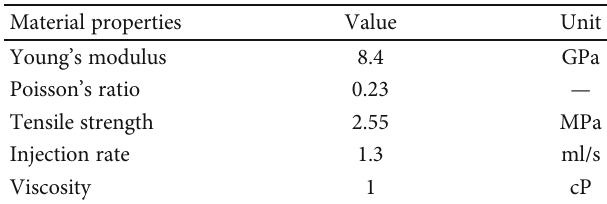
Figure 4: Geometric model and conditions in the simulation of lab-scale hydraulic fracture propagation with a preset slot. Table 1: Parameters used in the simulation of lab-scale hydraulic fracture